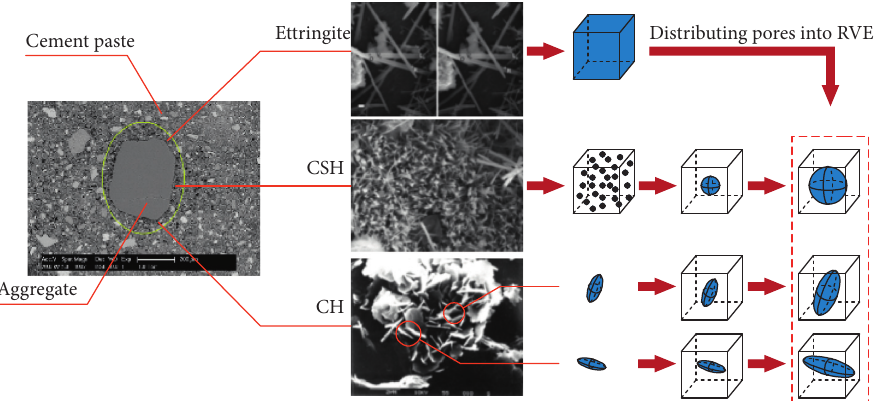
Figure 3: Equivalence of pores in phases of cement